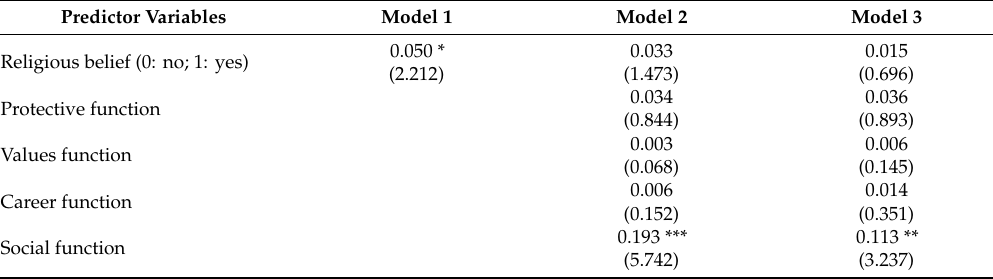
Table 4. Hierarchical regression results for volunteering frequency (N =